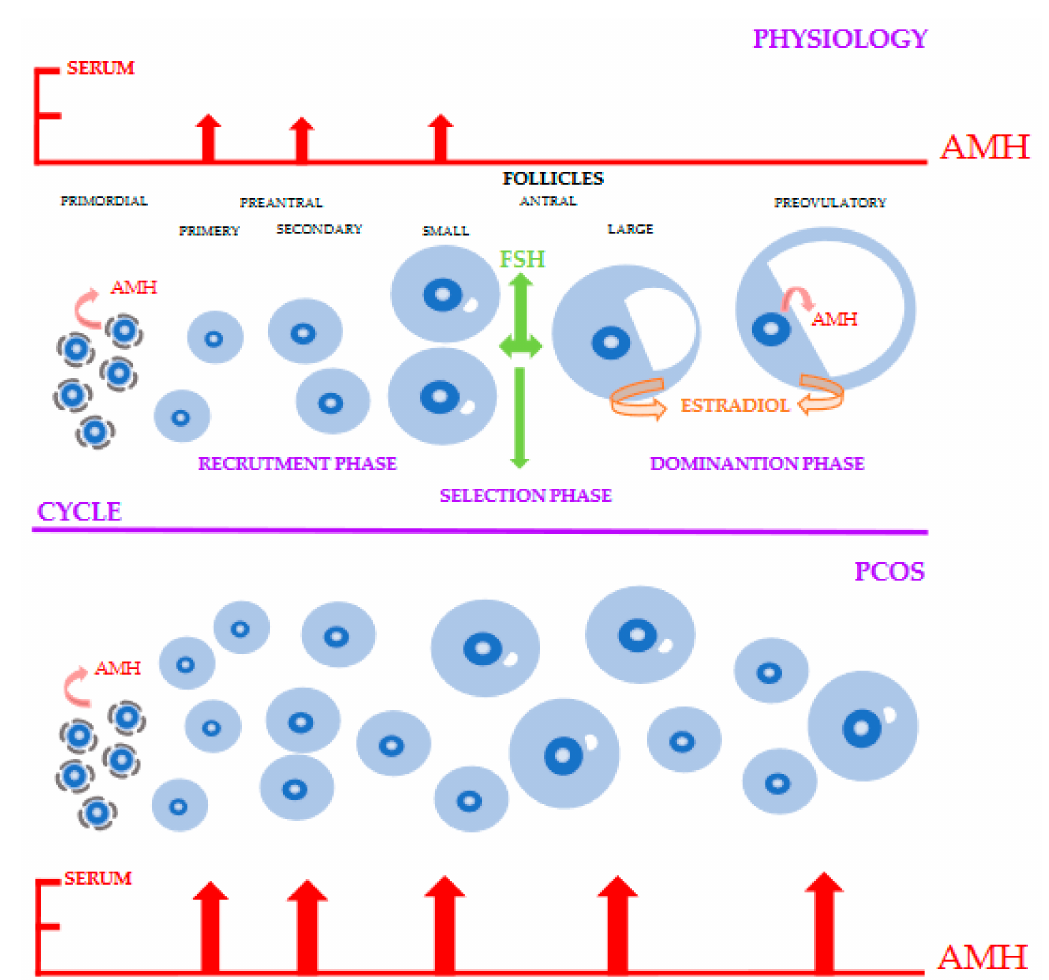
Figure 1. The roles of AMH (Anti-Müllerian Hormone) in PCOS (Polycystic Ovary Syndrome). In the physiological cycle, during the FSH (Follicle Stimulating Hormone) independent phase, AMH expression is lower in activated primordial follicles and highest in preantral and small antral follicles. In the FSH dependent phase, the expression of AMH is blocked. However, lower expression of AMH is observed in the preovulatory follicle. Therefore, the absence of AMH leads to an increased Estradiol level in antral and preovulatory follicles. In PCOS, the expression of AMH increases twofold, leading to an increased number of recruited follicles. In addition, such a high level of AMH reduces FSH expression and Estradiol synthesis, thereby blocking the selection phase and thus the formation of a preovulatory